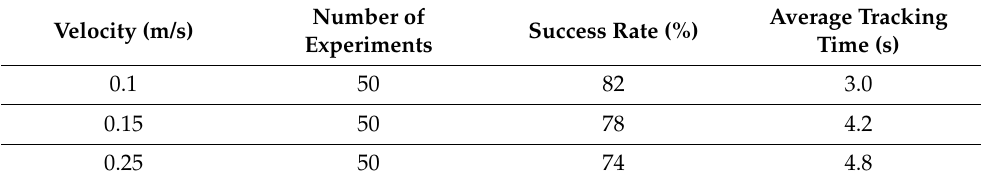
Table 6. Illumination variation tracking and grasping